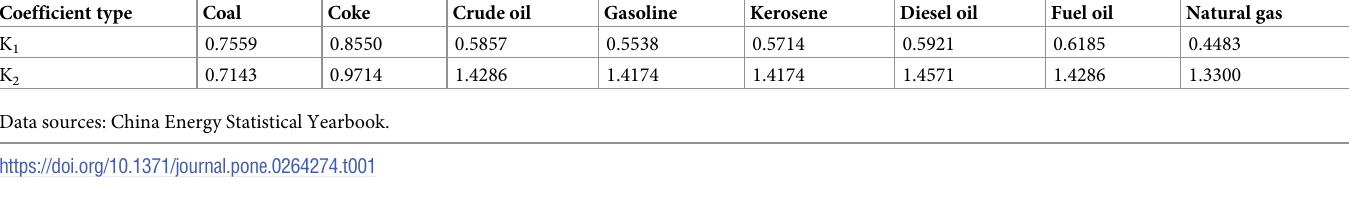
i0 in this paper is i